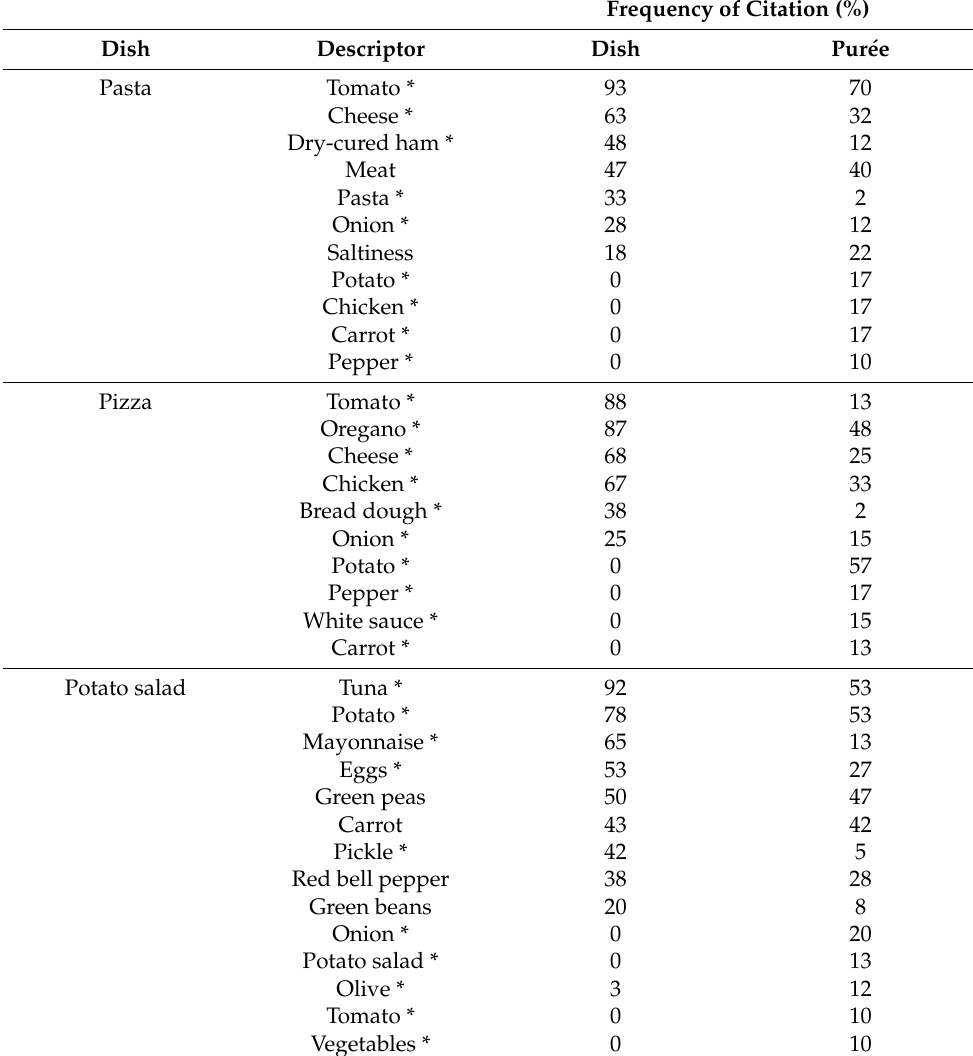
Table 1. Frequency of flavors descriptor elicited when tasting the dish and the pur é